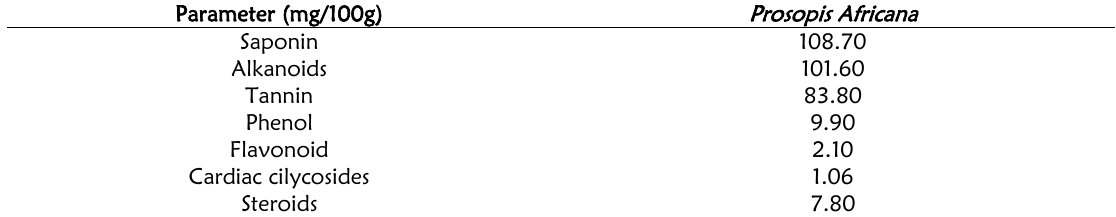
Table 4: Phytochemical analysis of Prosopis Africana pod